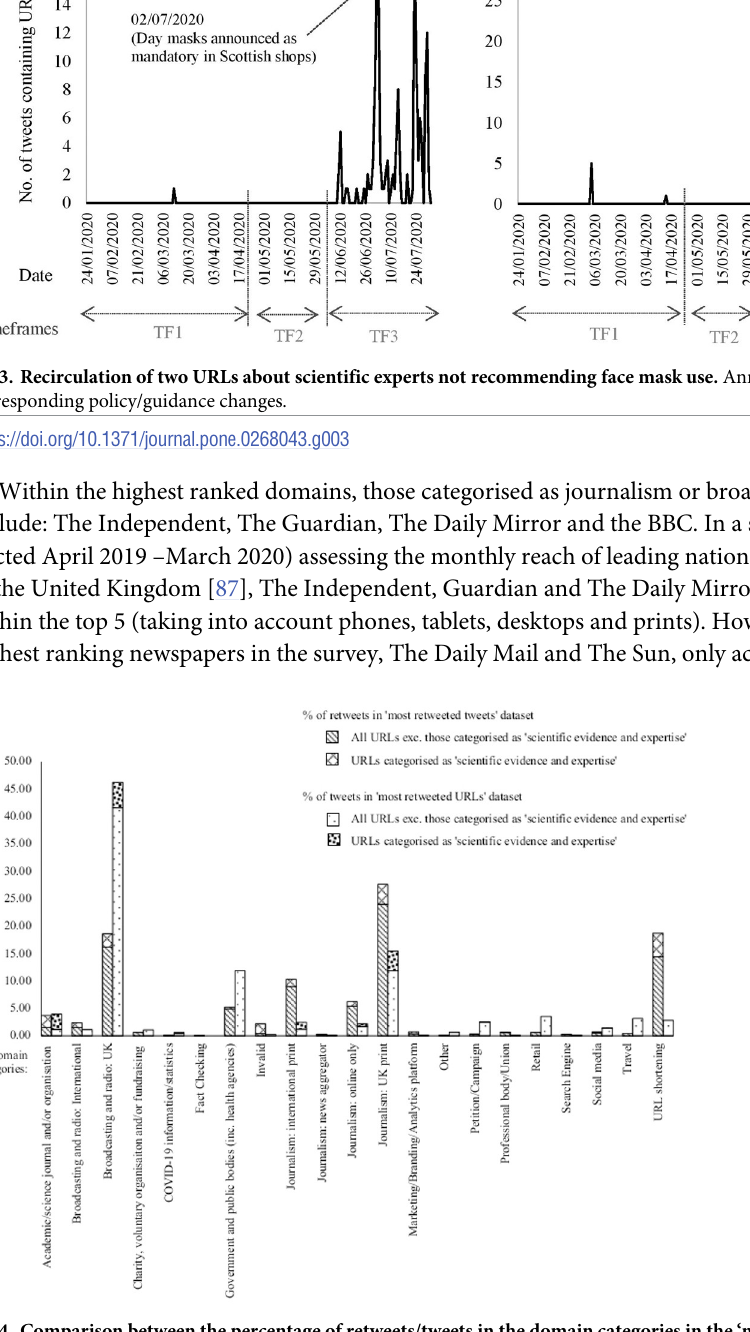
Fig 4. Comparison between the percentage of retweets/tweets in the domain categories in the ‘most retweeted tweets’ and ‘most tweeted URLs’ datasets and identifying whether the URL subject content was categorised as ‘scientific evidence and